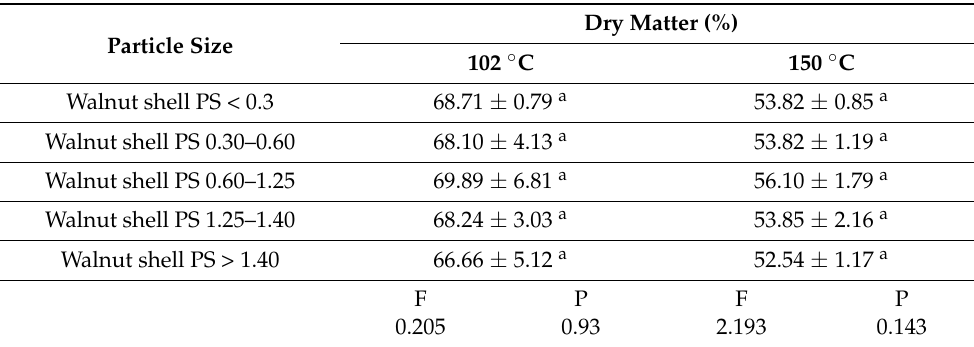
Figure 4. OH-number as a function of particle size. Obtained results have shown that dry matter depends on temperature and particle size. The lowest content of dry matter was at the smallest and at the biggest particle size of walnut shell (Table 5 and Figure 5). Table 5. Relationship between dry matter (%) and particle size (the same small letter (a) indicates that there is no significantly difference at p < 0.05).